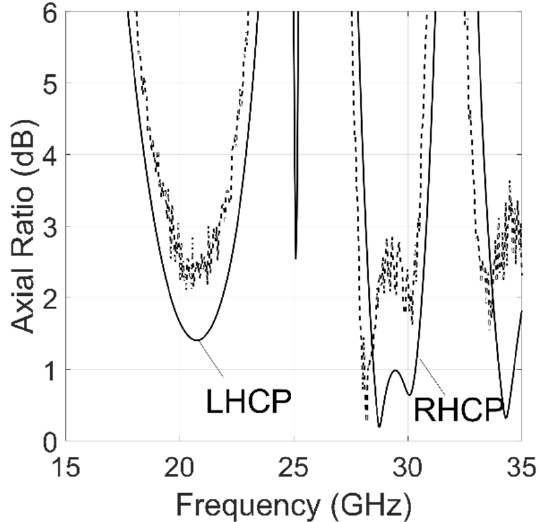
Figure 10. Simulated (continuous line) and measured (dashed line) ARs of the proposed converter. Glue layers have been included in the simulation.